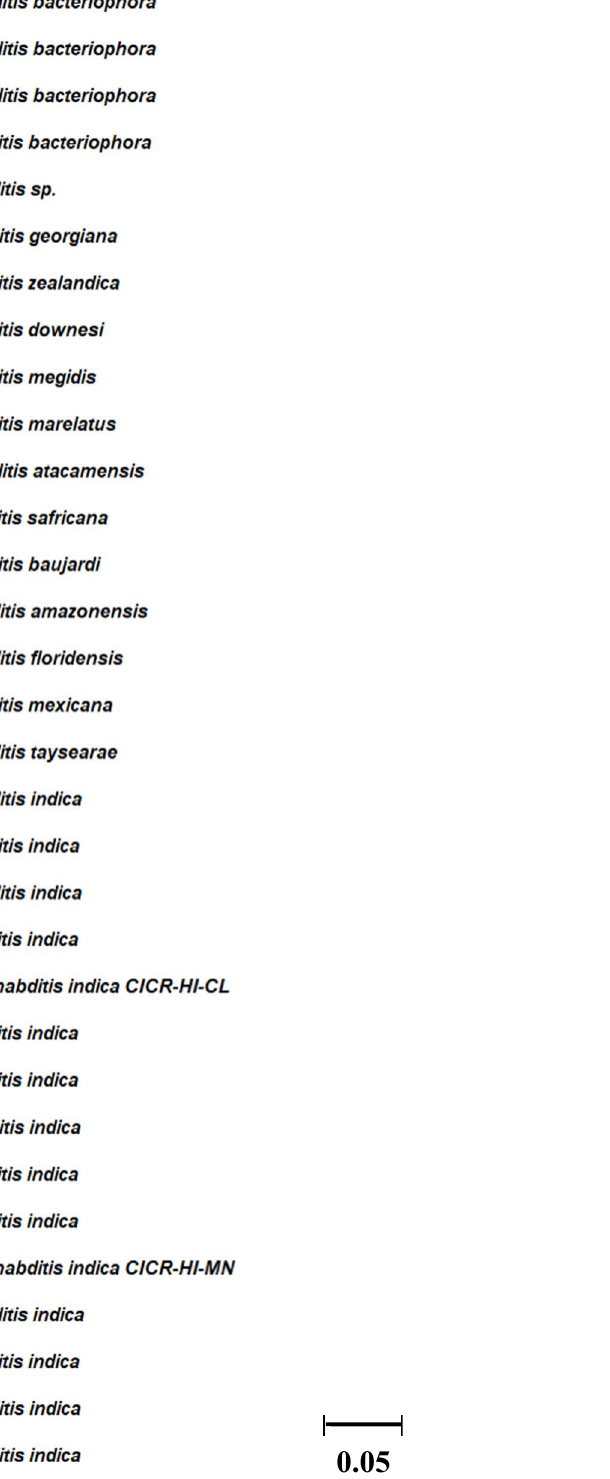
Fig. 2 Maximum likelihood based phylogenetic tree of Heterorhabditis spp. based on the analysis of ITS sequences with bootstrap values of 1000 replicates. GenBank accession numbers are given prefix to the Heterorhabditis